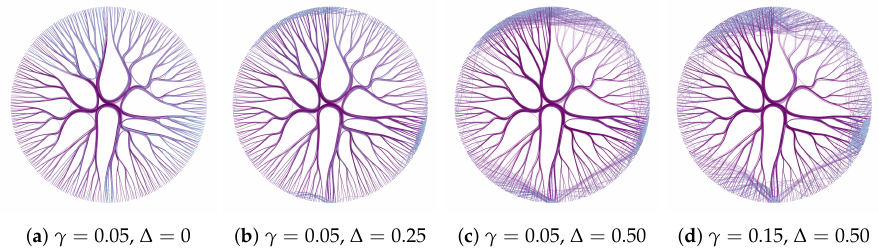
Figure 9. Multiples bundling configurations varying the edge tension parameters γ and ∆ . By properly setting up these parameters, hidden local information can be revealed separating small edges from the main bundles.